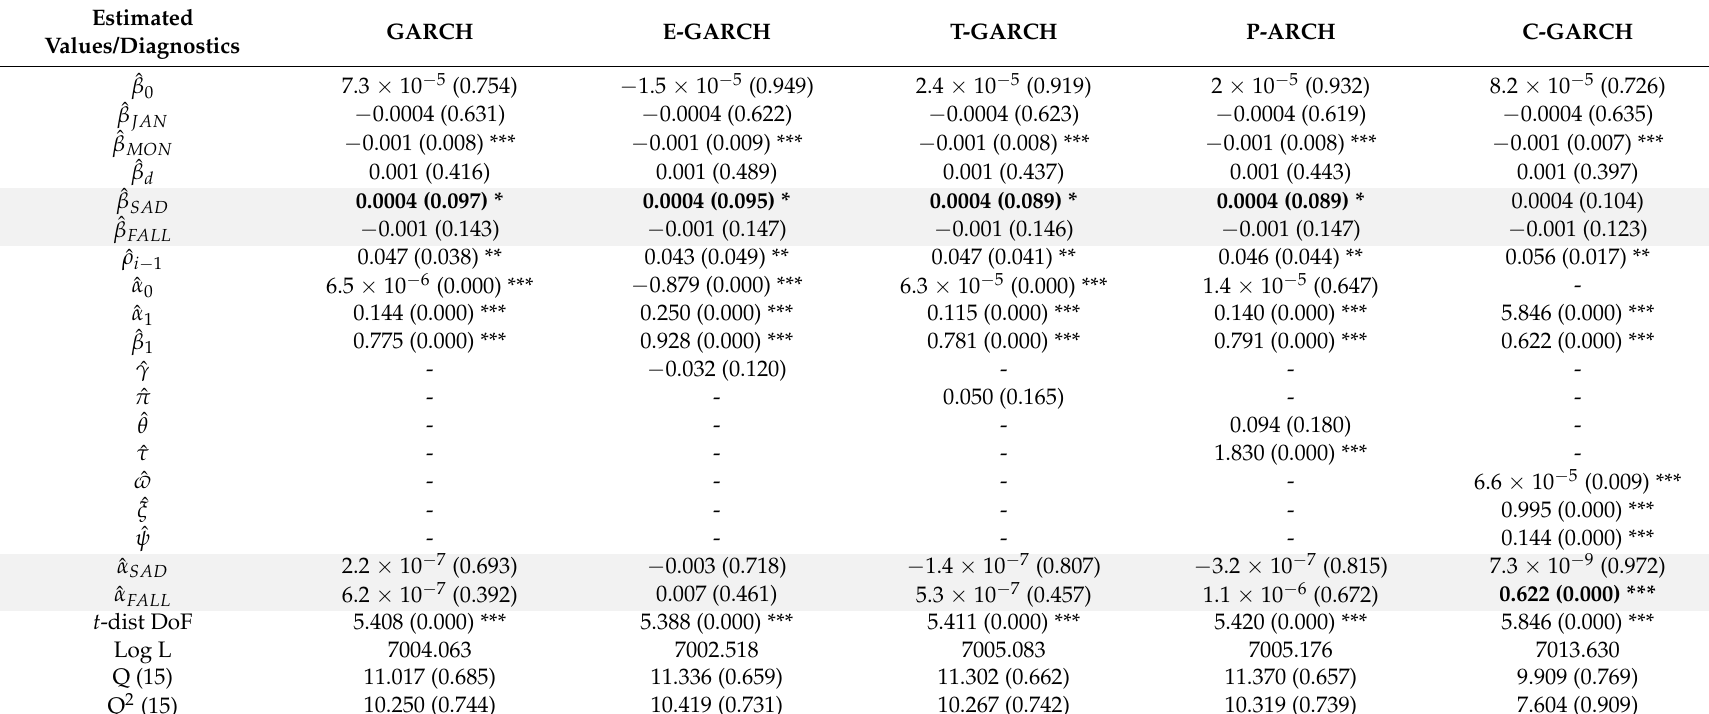
Table A6. Different GARCH specifications for